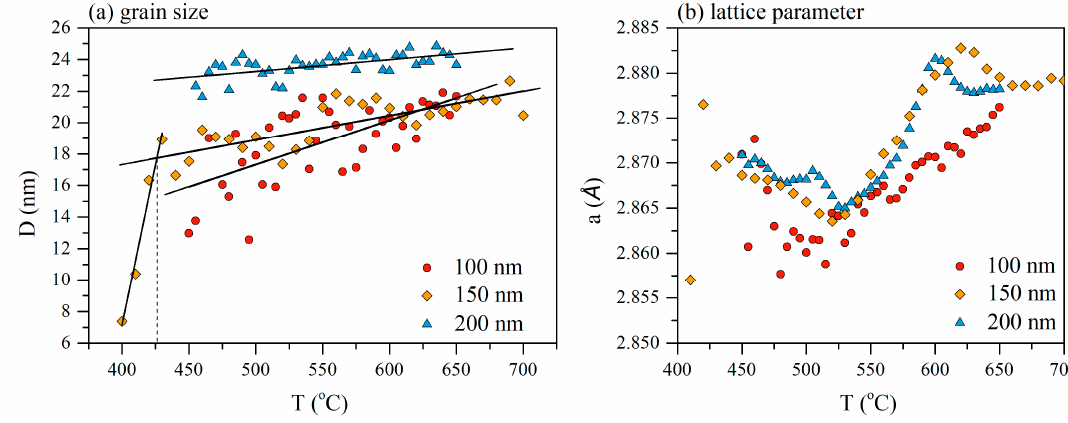
Figure 8. Grain size ( a ) and lattice parameter ( b ) dependence on temperature of the 100, 150 and 200 nm Fe 72.5 Nb 1.5 Mo 2 Cu 1.1 Si 14.2 B 8.7